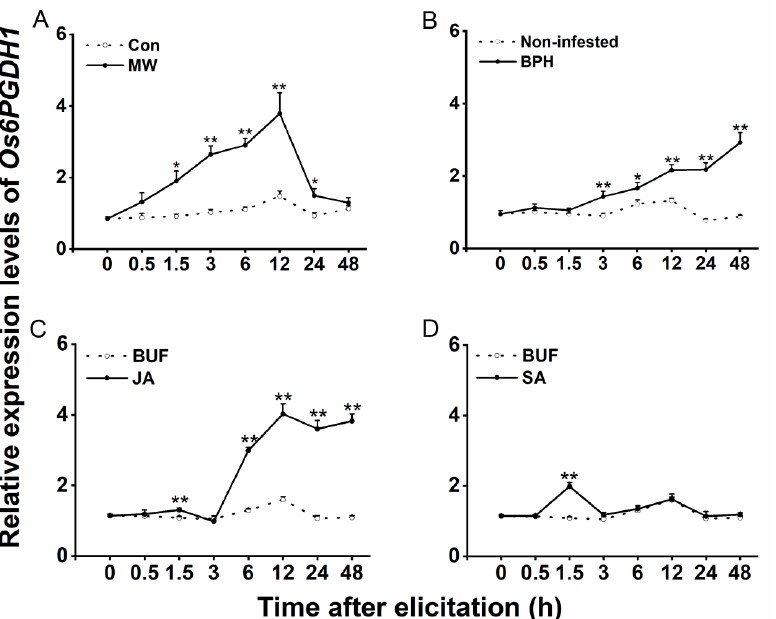
Figure 3. Transcript levels of Os6PGDH1 in rice after different treatments. Relative transcript levels